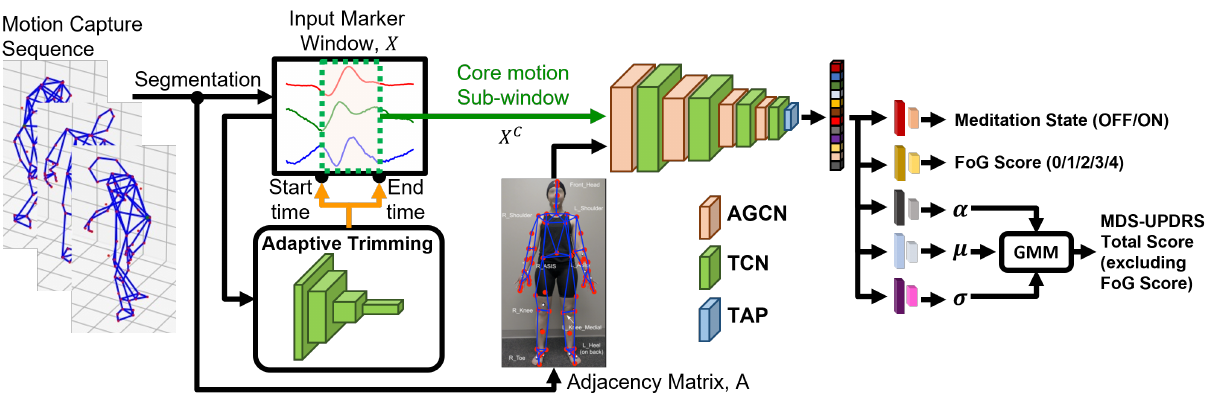
Figure 2. Overall model architecture. The recorded motion capture sequence is segmented into 4 s analysis windows, which are first processed with the Adaptive Trimming (AT) model. AT model, which uses a 4-layer temporal convolutional network (TCN), predicts the start and end index of the core motion segment that is most relevant for the prediction task. The core motion segment is processed with a 4-layer adaptive temporal-spatial graphical convolutional network (AGCN), which automatically learns the attention map for the most relevant joint and limb motion for the prediction task. The feature representation from the final layer of AGCN is processed with temporal average pooling (TAP) to summarize temporal information, which is then used to predict medication state, FOG score, and MDS-UPDRS-III total score (excluding FOG score) at the same time. Specifically for regressing the MDS-UPDRS-III total score (excluding FOG score), Gaussian Mixture Model (GMM)-based regressor is used to take account of the non-Gaussian distribution of the target